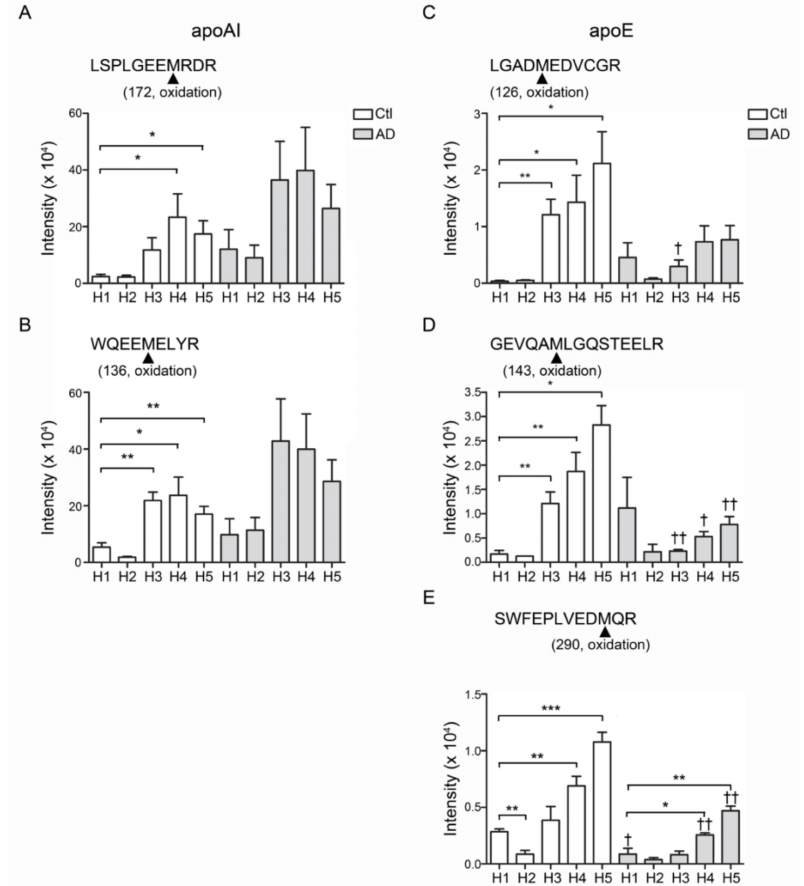
Figure 4. The post-translational modification of apoA1 and apoE in HDL. The oxidation was found and increased on the position 136 and 172 methionine (136M, 172M) of apoAI ( A ) peptide sequences WQEEM*ELYR and ( B ) LSPLGEEM*RDR. The position 126, 143 and 290 methionine (126M, 143M, 290M) of apoE was also oxidized. ( C ) peptide sequences LGADM*EDVCGR. ( D ) GEVQAM*LGQSTEELR. ( E ) SWFEPLVEDM*QR. * p < 0.05, ** p < 0.01. * p <